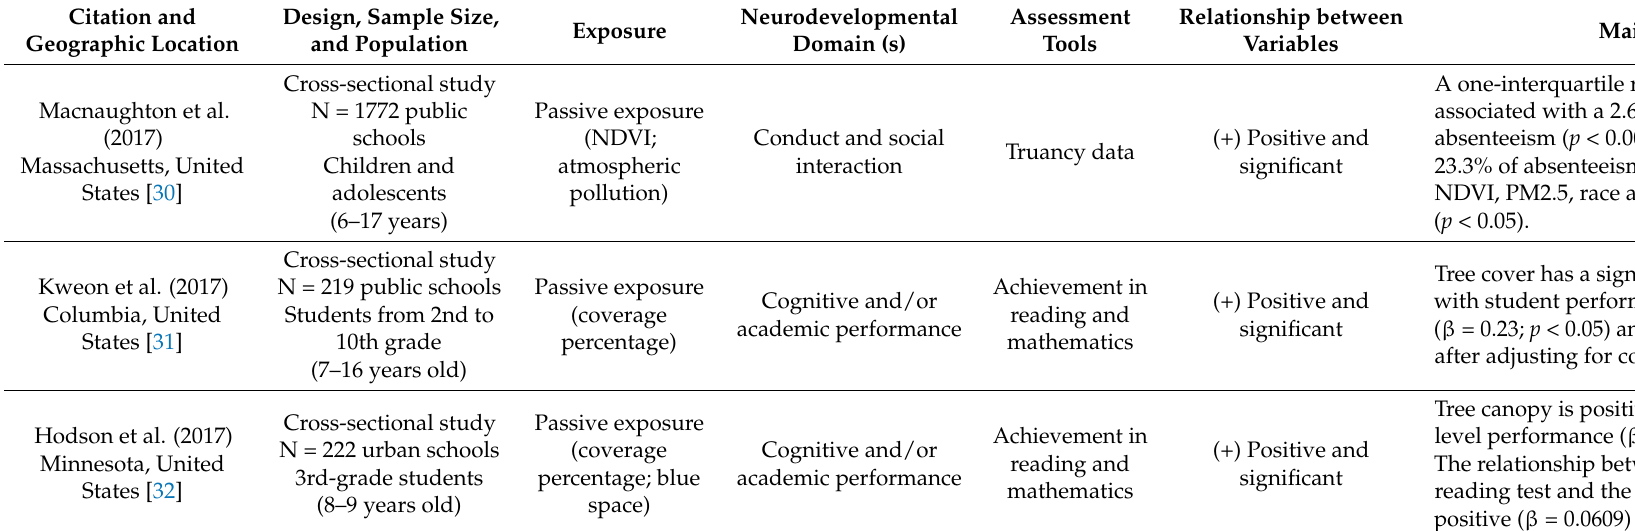
Table 3. Main characteristics of the included studies in the